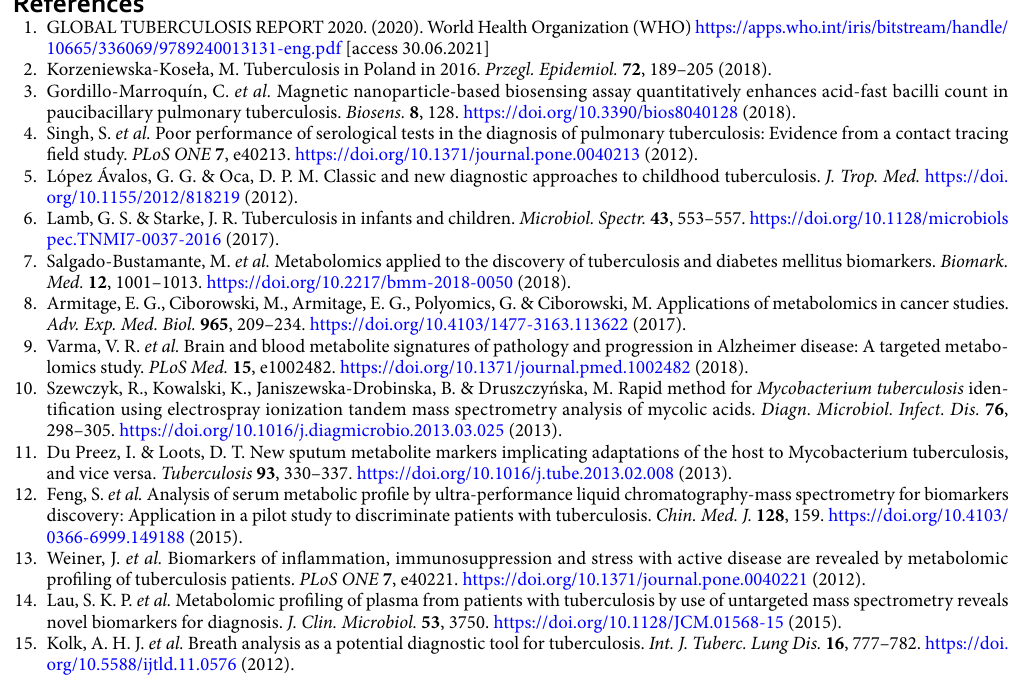
Supplementary Table S4. Chromatographic separation was conducted under HILIC conditions on an Agilent Poroshell 120 HILIC-Z 3.0 × 100 mm 2.7 µm. The major liquid chromatography parameters were as follows: injection volume, 10 µl; flow, 500 µl/min; column temperature: 40 °C. The mobile phase consisted of water (A) and 90% acetonitrile in water (B), both with the addition of 20 mM ammonium formate with 0.1% formic